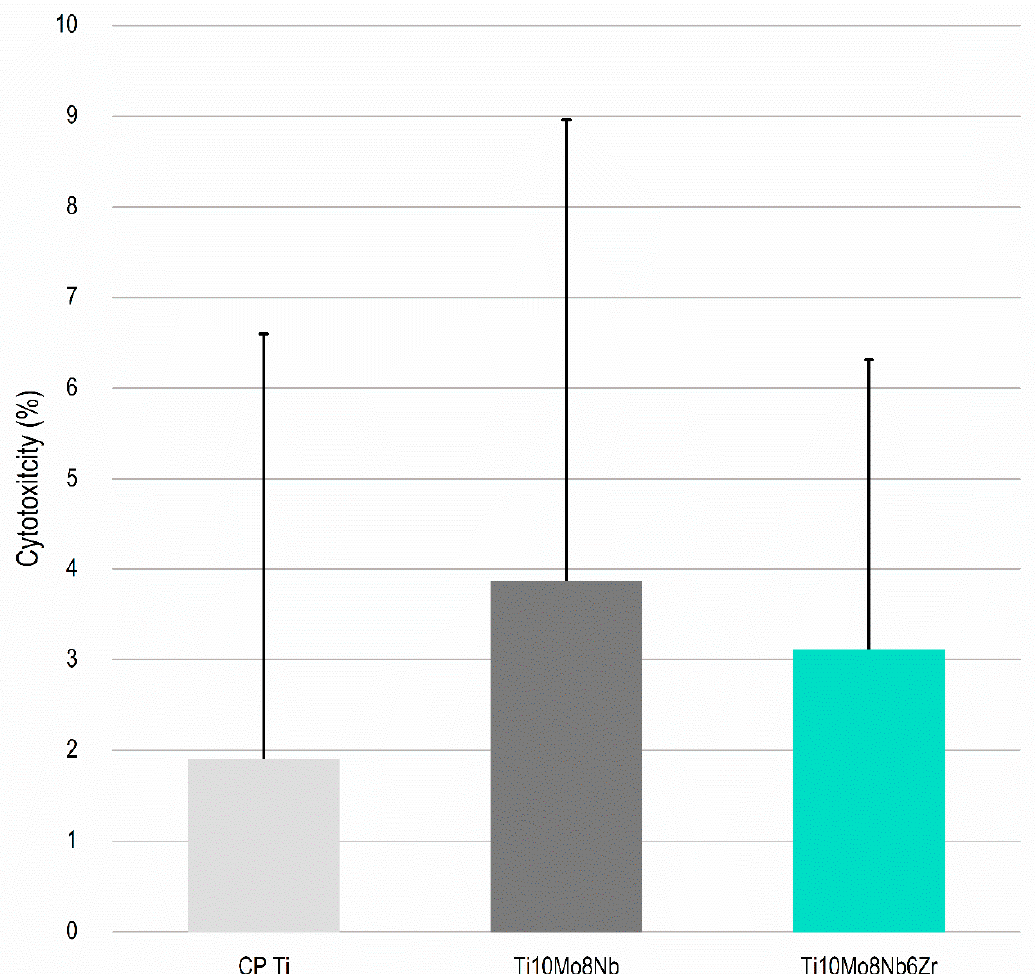
Figure 6. Cytotoxicity evaluation of the Ti 10 Mo 8 Nb 6 Zr alloy. LDH analysis on surfaces of the CP Ti, Ti 10 Mo 8 Nb, and Ti 10 Mo 8 Nb 6 Zr alloys after one day of cell culture. The columns indicate the average values, and the bars indicate the standard deviation.